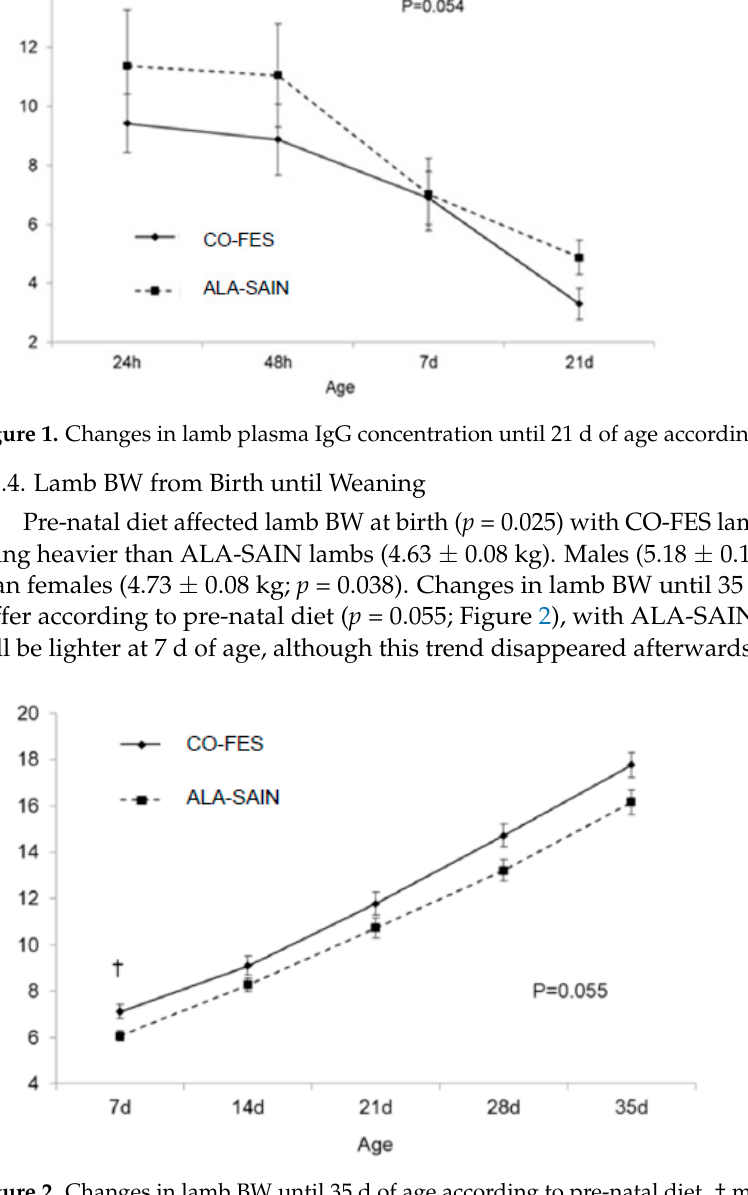
Figure 2. Changes in lamb BW until 35 d of age according to pre-natal diet. † means statistical trend (0.05 < p < 0.10).